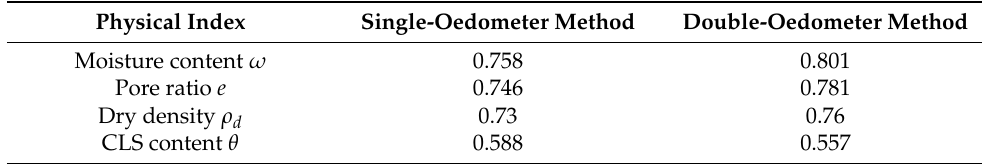
Table 3. Grey correlation degree of physical